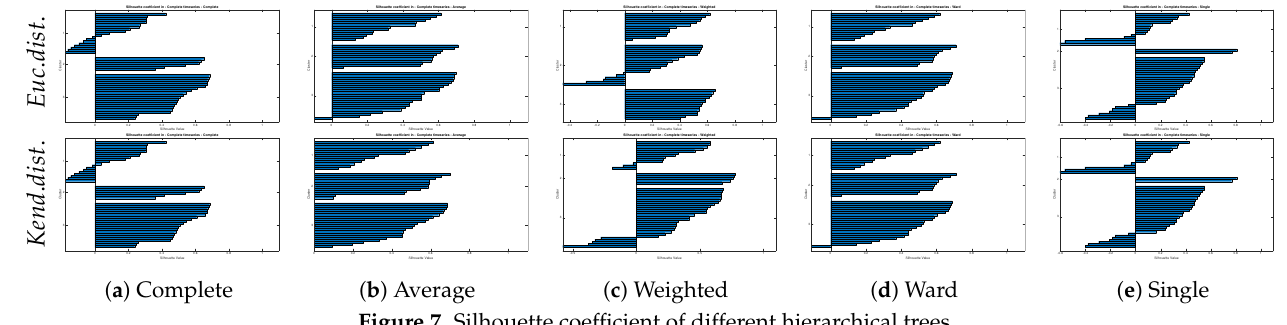
Figure 7. Silhouette coefficient of different hierarchical